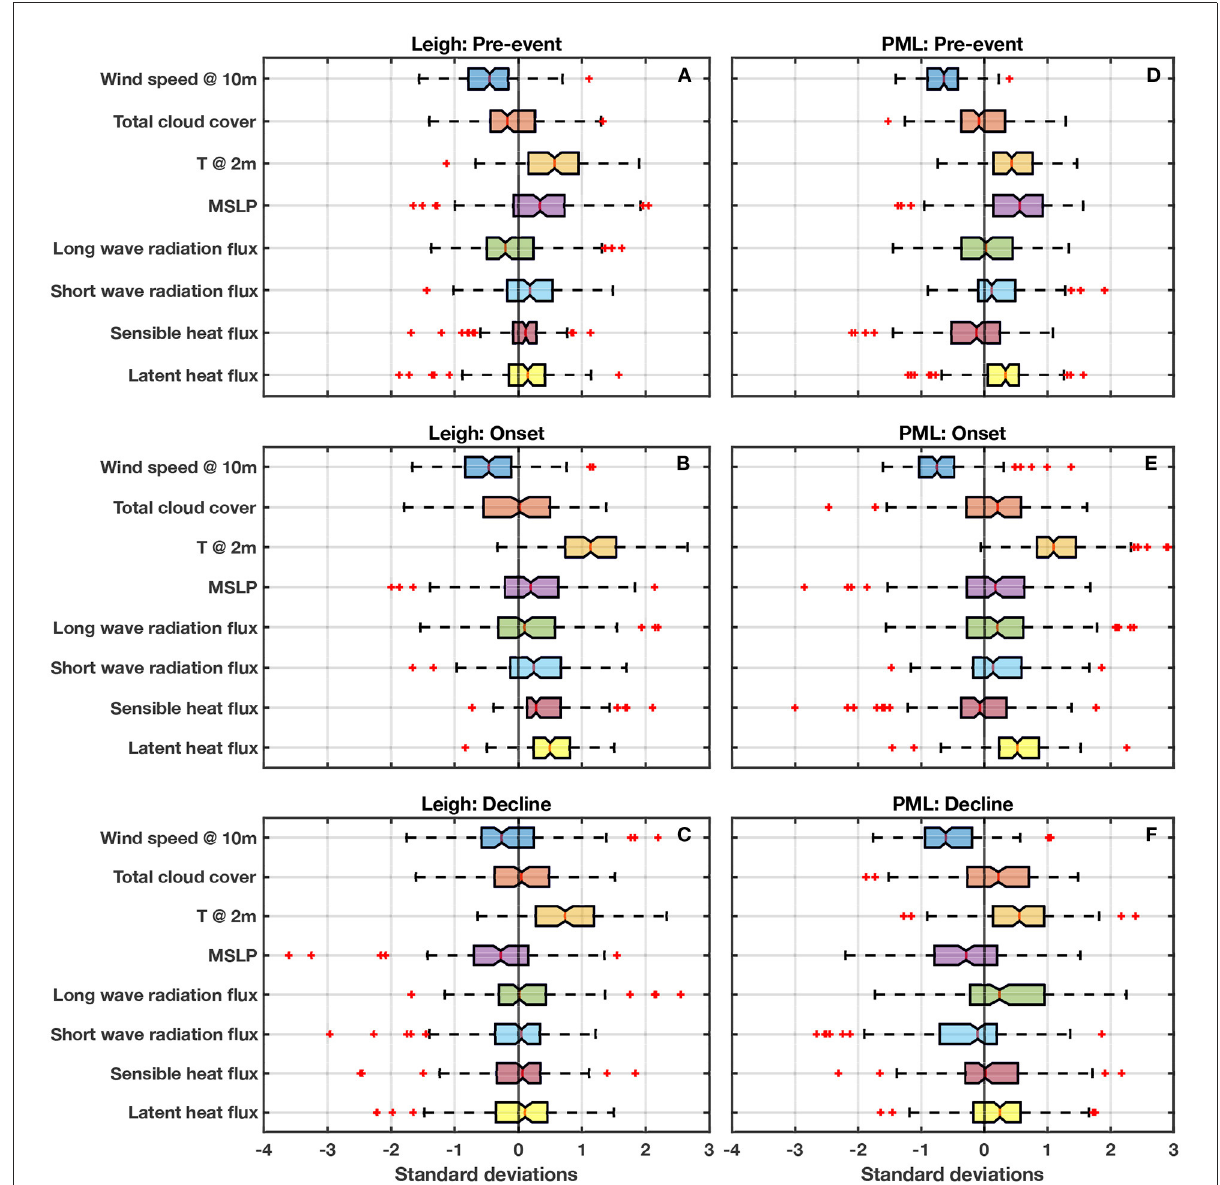
FIGURE7 Notched box and whisker plots of normalized atmospheric anomalies averaged over the specified phase for each MHW detected at Leigh and PML. The pre-conditioning phase (A,D) is 7 days before the start of a MHW, onset (B,E) is from the start of the event to the peak intensity date, and decline (C,F) is from the peak intensity date to end of event. Outliers are shown as red